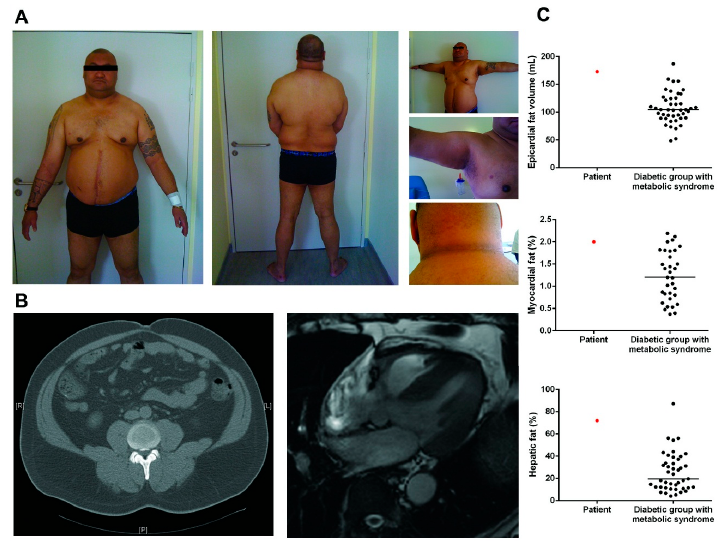
Figure 1. Patient’s description. ( A ) Photographs of the patient carrying the heterozygous ZMPSTE24 missense mutation L438F, showing an accumulation of facial and cervical fat, android obesity, acanthosis nigricans, and no lower limb lipoatrophy; ( B ) Abdominal CT scan and cardiac-MRI of the patient showing the presence of superficial and deep subcutaneous adipose tissue and accumulation of cardiac ectopic fat; ( C ) Quantification of patient epicardial fat volume, myocardial, and hepatic triglyceride content using 3T MRI and proton magnetic resonance spectroscopy ( 1 H-MRS). Comparison of patient’s ectopic fat depots with a group of type 2 diabetic subjects with metabolic syndrome matched for age and BMI.